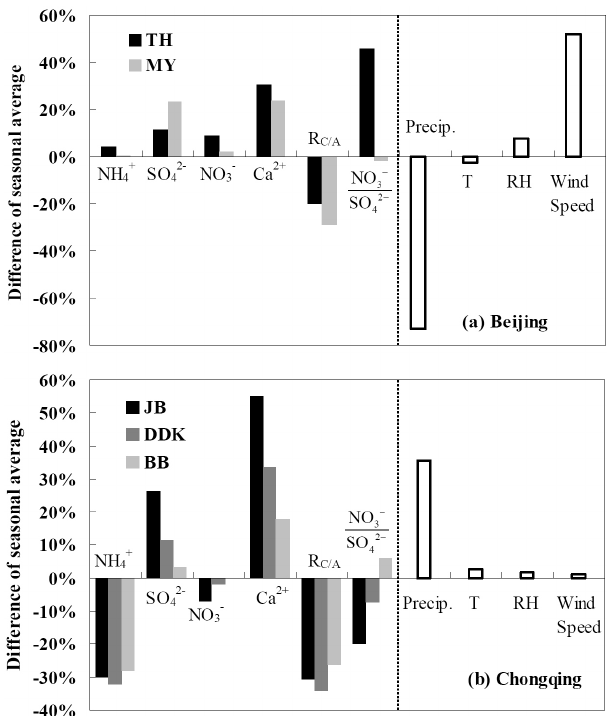
Fig. 6. Differences of R C / A , NO − /SO 2 − , concentrations of as- 3 4 sociated ionic species and meteorological factors between the two springs of 2005 and 2006 for (a) Beijing (TH and MY) and (b) Chongqing (JB, DDK and BB), which were calculated based on (2006–2005)/2005 and (2005–2006)/2006,